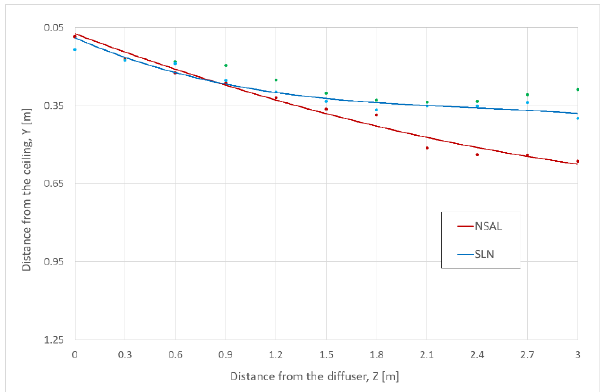
Fig. 13 . Comparison of ranges of tested diffusers at 120 m 3 /h flowrate, outflow lateral (along with the ceiling).